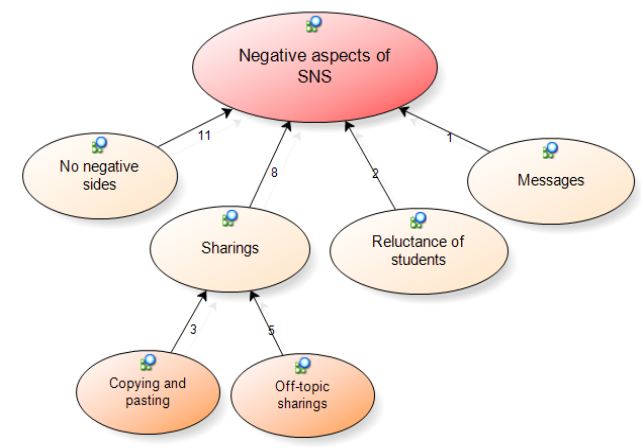
Figure 4. Model related to the negative aspects of using the social networking site.